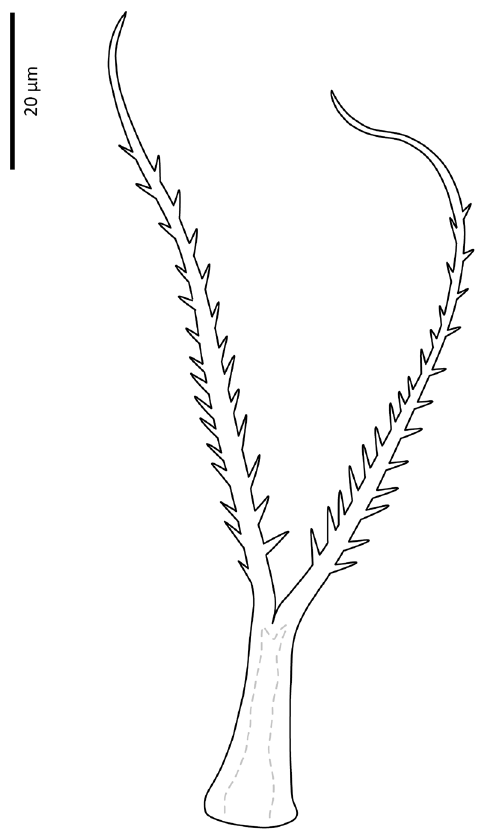
Figure 4. Zygoseius papaver sp. n., female, tritosternum. indistinct; shield widest past level of st5 , with posterior margin truncate; closely abut- ting ventrianal shield. Setae st5 smooth, inserted near shield lateral margins; poroids iv5 near posterolateral margins of shield. Ventrianal shield subpentagonal, expanded, wider than long, 113–121 long, 147–180 wide (length/width ratio: 0.70–0.80), straight anteriorly between setae ZV1 . Shield distinctly lineate anteriorly, distinctly punctate posteriorly and medially, weakly lineate posterad JV2 level, with small punc- tae in lateral margins; shield with five pairs of pre-anal and three circum-anal setae, all smooth. Setae JV1 – 2 subequal, 1.5–2× as long as other setae (Table 1); para-anal setae inserted near level of anterior margin of anal opening; gland openings gv3 on posterolateral margins of shield near mid-level of anus; cribrum well-developed, with a few narrow transversal strips of spicules; anal opening 20–25 long, 18–22 wide, sub- triangular to ovoid, located in posterior fourth or third of shield. Peritreme 175–198 long, densely covered by aciculae, extending anteriorly almost to level of seta z1 , with one gland pore ( gp ) located at mid-level of coxa II. Peritrematal shield wide, essentially in ventral position; completely fused to exopodal, parapodal and metapodal